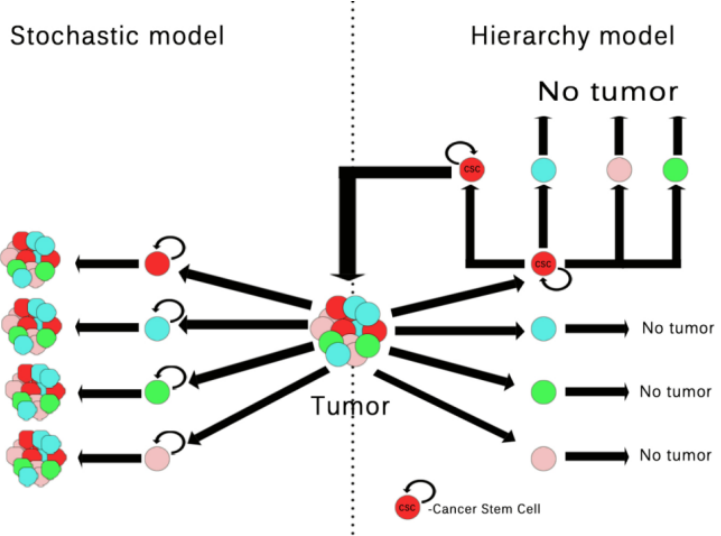
Figure 1. Theory of malignant transformations from adult stem cells. On the left, the stochastic model postulates that several cancer cell types have an equal ability to regenerate and proliferate, each one being capable of giving birth to another tumor (the green, pink, blue and red cells represent similar, non-stem tumoral cell populations); On the right, the hierarchy model postulates that only a specific population (cancer stem cells represented by the red cells marked with a CSC in the middle) has the distinct ability to regenerate, multiply and to differentiate into other subset populations (the green, blue and pink cells), hence giving birth to other